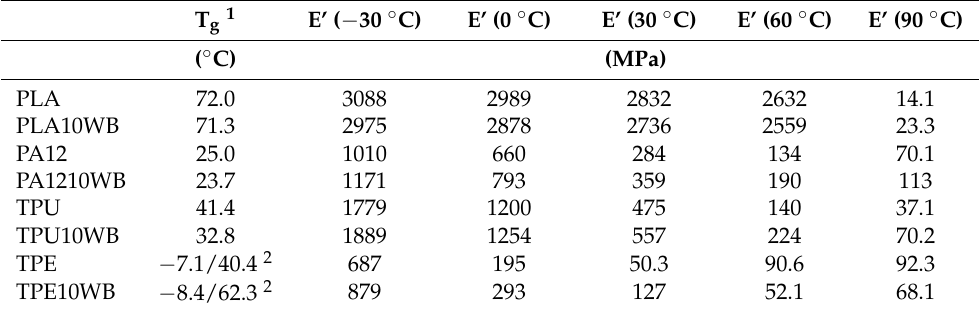
Table 6. Dynamic mechanical analysis (DMA) of WB-based